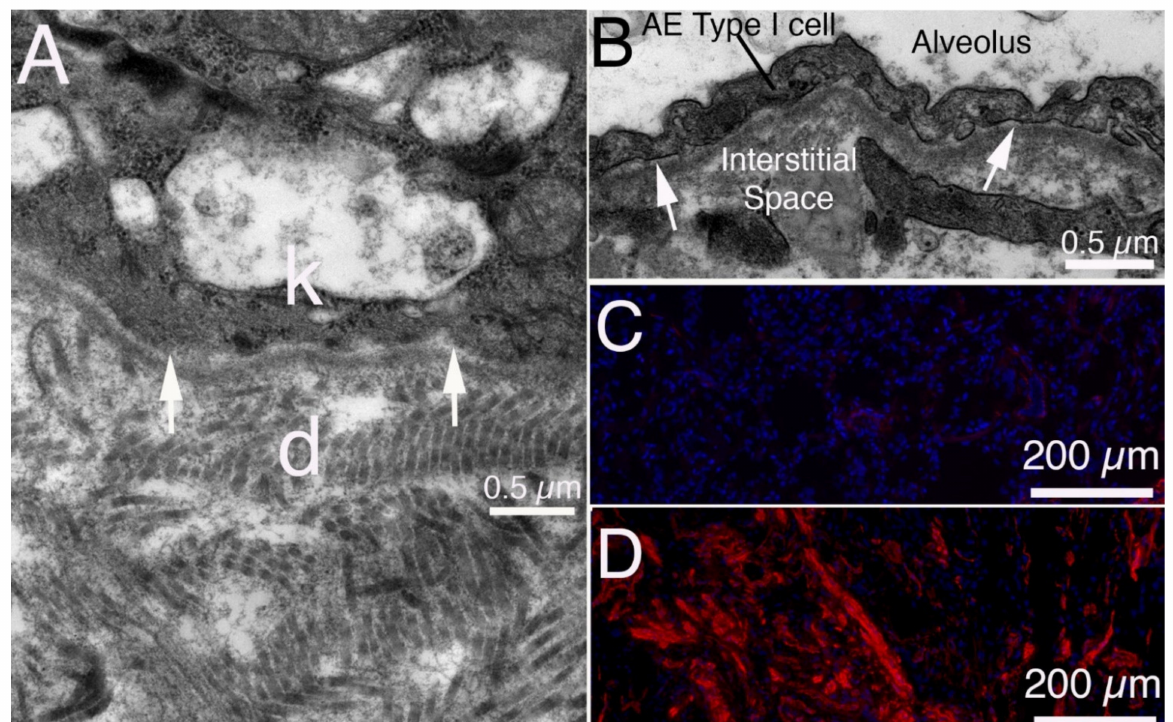
Figure 8. Organs where BMs can have a role in fibrosis [43]. ( A ) TEM in normal rabbit skin. The basal keratinocyte (k) and dermis (d) are separated by the BM with lamina lucida (arrows) and lamina densa. Note the larger and more disorganized fibrils in the dermis compared with corneal stroma in Figure 3b. ( B ) TEM in normal rabbit lung. The alveolar BM with lamina lucida (arrow) and underlying lamina densa separates the alveolar epithelial cell type I (AE cell type I) from the interstitial space. ( C ) IHC for SMA in normal human lung primarily stains pericytes associated with blood vessels. There is little staining for SMA in the normal lung parenchyma. Blue is DAPI stained nuclei. ( D ) In a human lung with advanced idiopathic pulmonary fibrosis (IPF) SMA-positive myofibroblasts are present throughout the parenchyma. Blue is DAPI stained